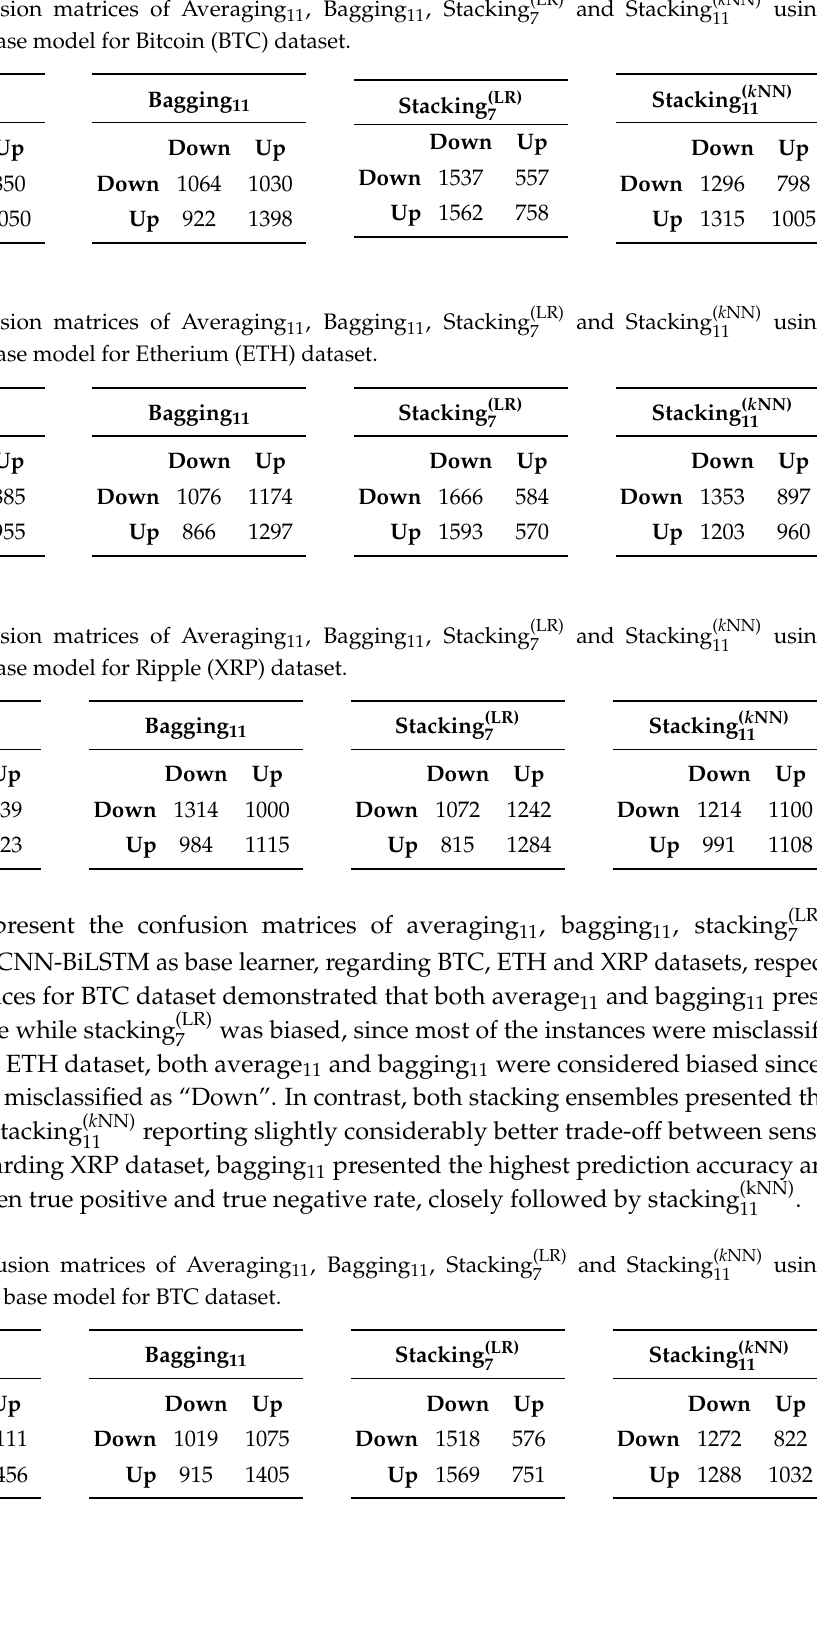
Table 7. Confusion matrices of Averaging 11 , Bagging 11 , Stacking (LR)